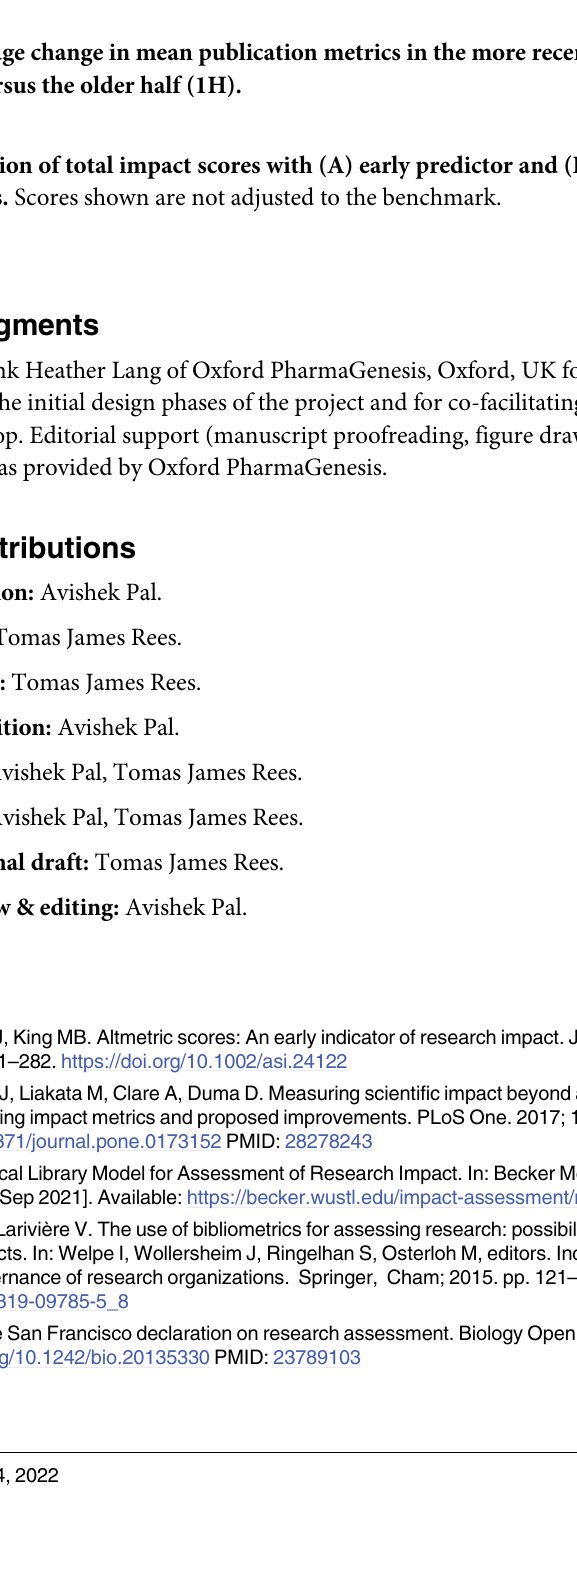
S3 Table. Three-factor analysis of included metrics in (A) the full sample, (B) older papers (1H), and (C) younger papers (2H). Highest loadings for each metric are shown in bold. (DOCX) S4 Table. Two-factor analysis of metrics excluding citations in policy documents, PubMed guidelines, and patents in (A) the full sample, (B) older papers (1H), and (C) younger papers (2H). Highest loadings for each metric are shown in bold. S1 Fig. Percentage change in mean publication metrics in the more recent half of the publi- cations (2H) versus the older half (1H). (TIF) S2 Fig. Correlation of total impact scores with (A) early predictor and (B) intermediate predictor scores. Scores shown are not adjusted to the benchmark.